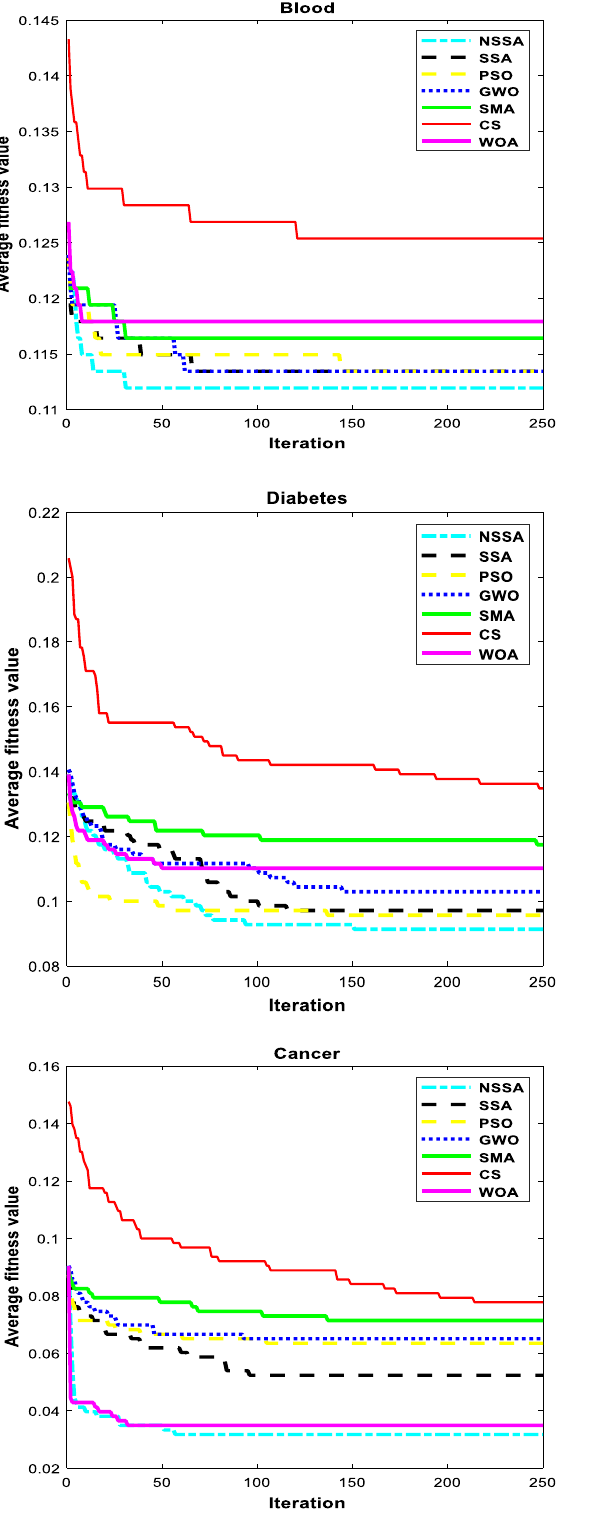
Fig. 3 Average iteration curve during classification